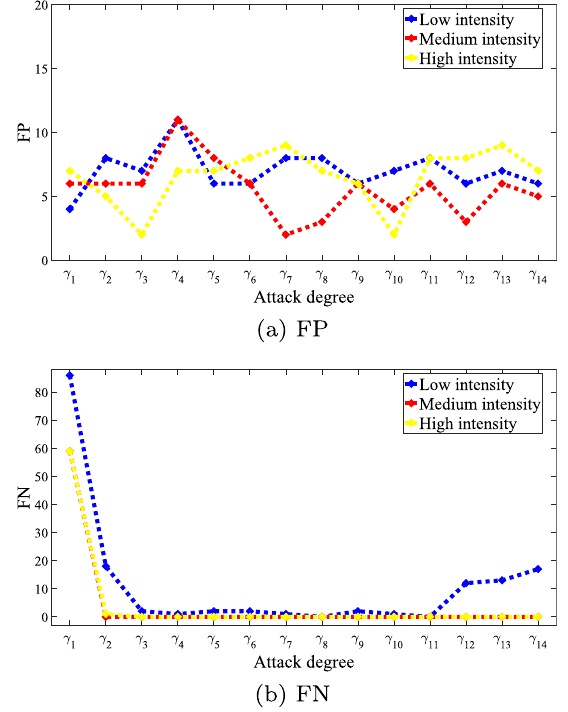
Fig. 6 The number of a FP and b FN obtained under different attack intensities and